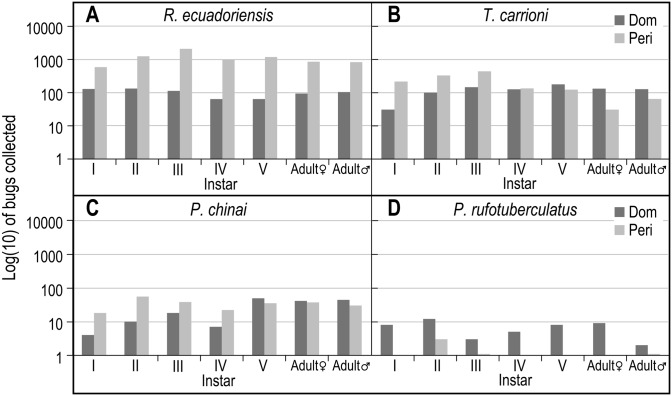
Population structure of triatomines collected in rural communities of Loja Province, Ecuador.Number of live Nymphal I—V instars and adult female and male bugs collected in domestic (Dom) and peridomestic (Peri) habitats. A) R. ecuadoriensis, B) T. carrioni, C) P. chinai and D) P. rufotuberculatus.